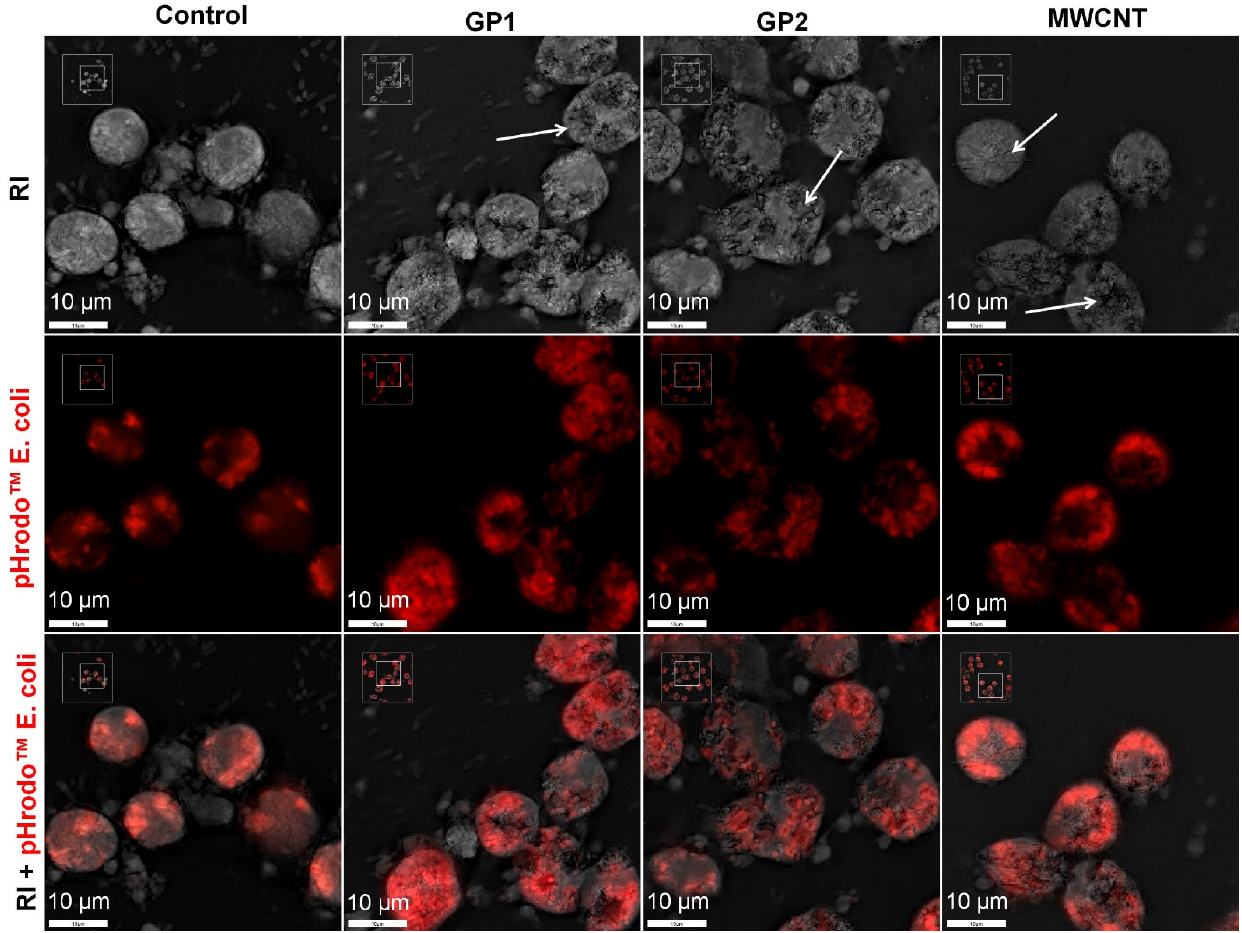
Figure 5. Internalization of EC (red) by primary monocytes pre-treated with GPs (60 μ g/mL) and MWCNTs (30 μ g/mL) (white arrows) compared to control after 3 h of exposure. Representative images taken using holotomographical microscopy. RI—refractive index.